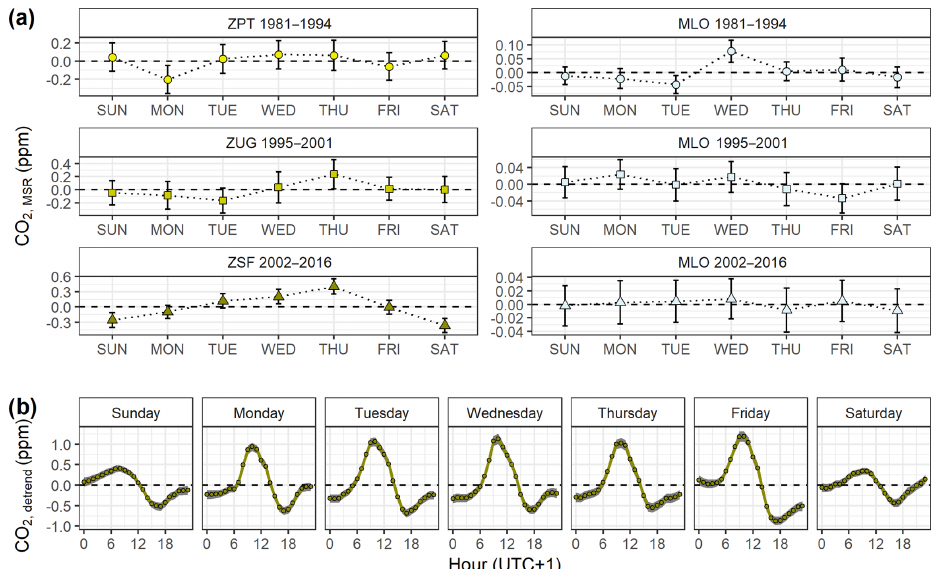
Figure 4. (a) Mean MSR CO 2 values at Mount Zugspitze and MLO as a function of the day of the week. Mean MSR values are adjusted such that they sum to 0. (b) Detrended mean CO 2 diurnal cycles at ZSF by day of the week from 2002 to 2016. Uncertainties at the 95% confidence interval are shown by the shaded